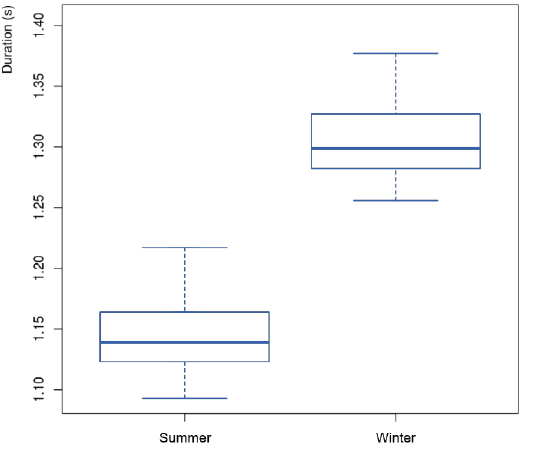
Figure 4. Movement durations in summer and winter.